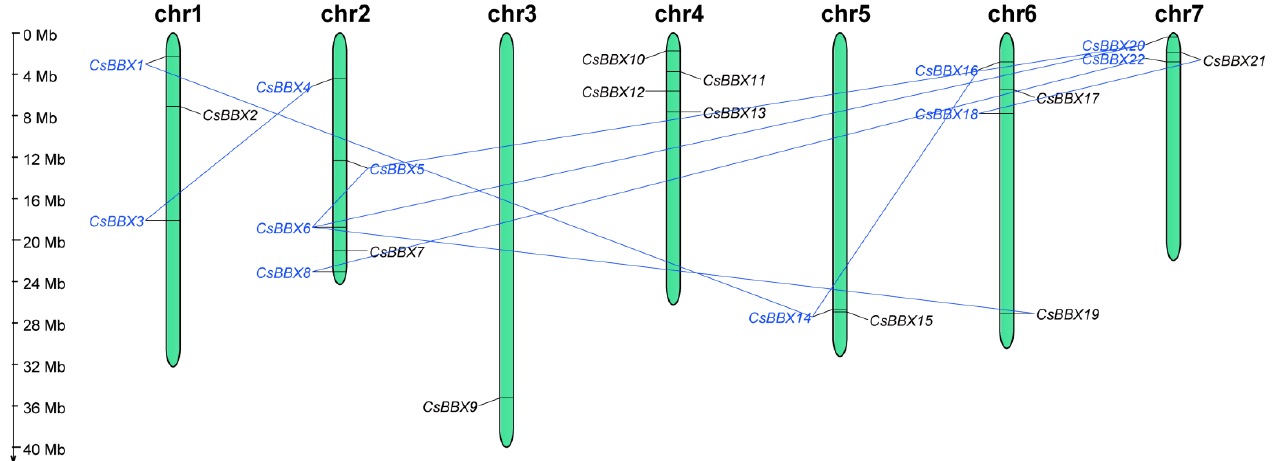
Figure 3. Distribution of the CsBBX genes on seven cucumber chromosomes. The scale on the left represents megabases (Mb). The segmental duplication genes are marked with blue lines.